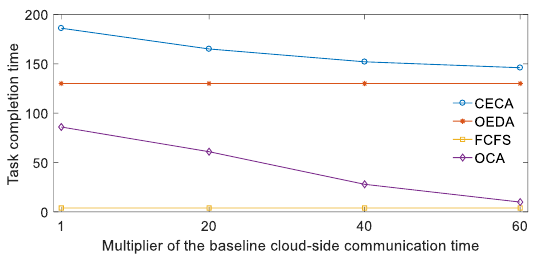
Figure 6. Impact of cloud-edge communication time on the number of tasks completed by different algorithms.